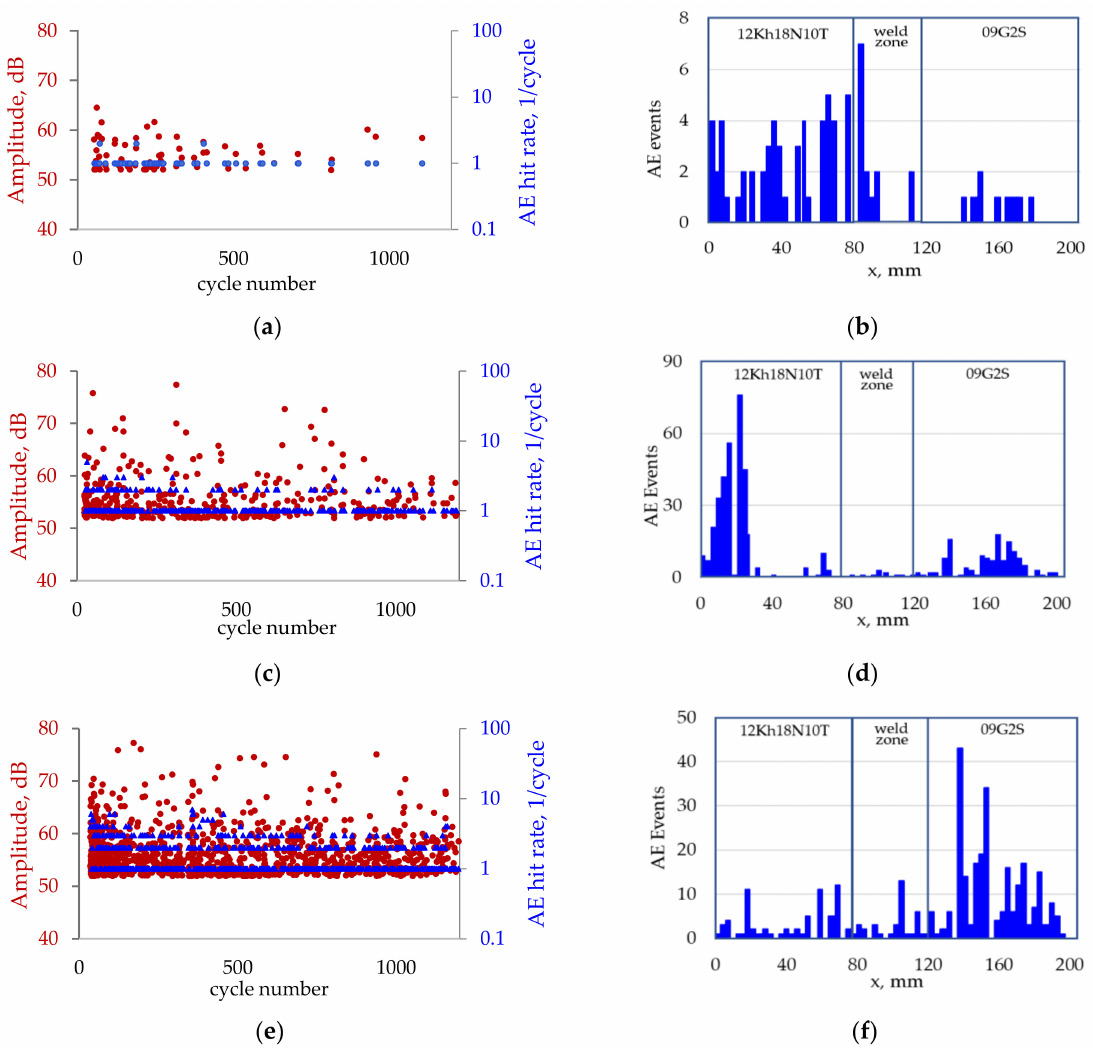
Figure 5. AE data obtained during cyclic loading of a welded joint without diffusion interlayers. Location of AE events at σ max = 200 MPa ( a ), σ max = 300 MPa ( c ), σ max = 400 MPa ( e ); AE hit count rate values at σ max = 200 MPa ( b ), σ max = 300 MPa ( d ) and σ max = 400 MPa ( f ).